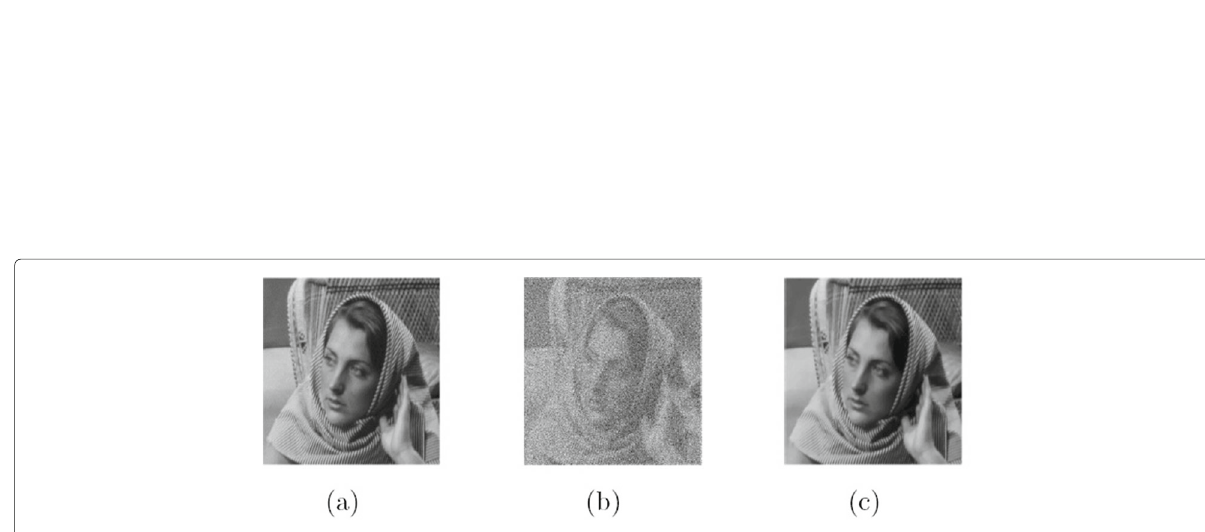
Fig. 17 Restored result on Barbara; a true image; b noisy image with σ = 15 ; c recovered with method